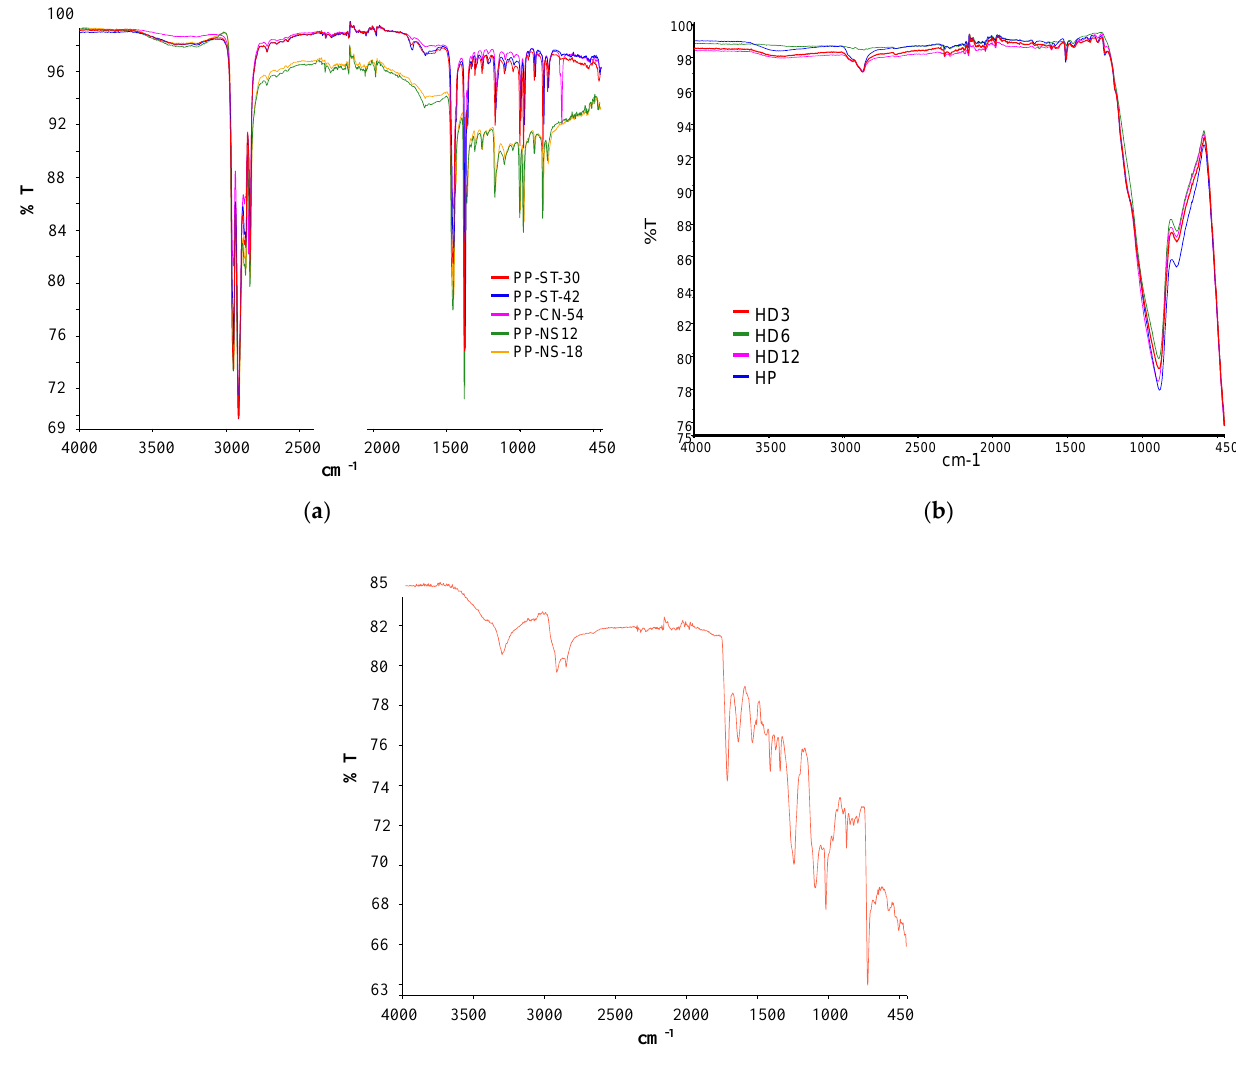
Figure 13. FT-IR of fibers. ( a ) Polypropylene fibers; ( b ) glass fibers; ( c ) pneumatic textile fibers.